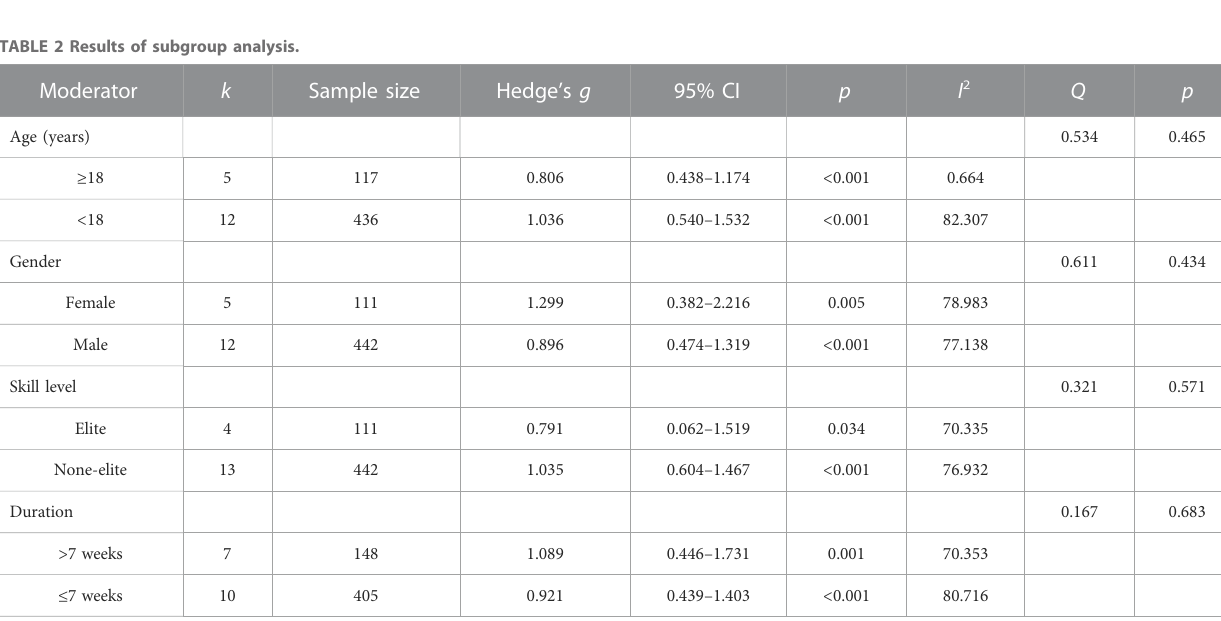
TABLE 2 Results of subgroup